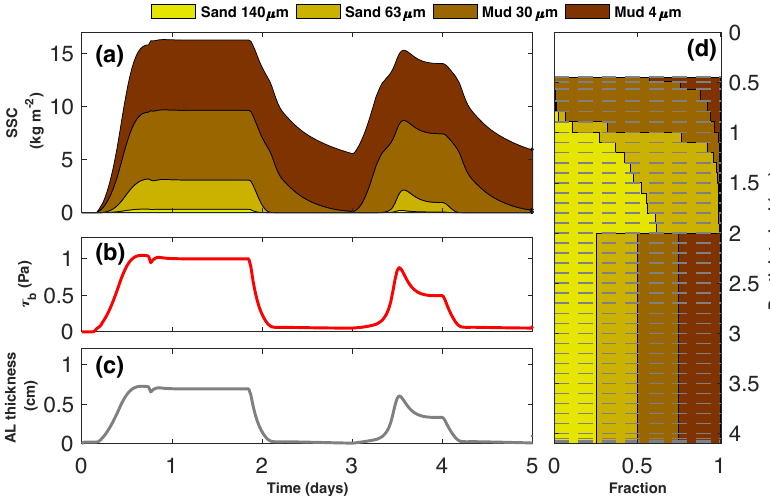
Figure 5. Summary of the double resuspension experiment with non-cohesive sediment over 5 days. The model setup included 41 bed layers, a minimum new layer thickness of 1mm, and four non-cohesive classes. The top horizontal panel (a) shows the time evolution of the mass of sediment in suspension colored by size class. The middle horizontal panel (b) is the time series of bottom stress, and the bottom horizontal panel (c) shows the corresponding time series of active-layer thickness. The right panel (d) depicts the final stratigraphy relative to the initial bed level at zero and shows the fraction of each sediment class in each bed